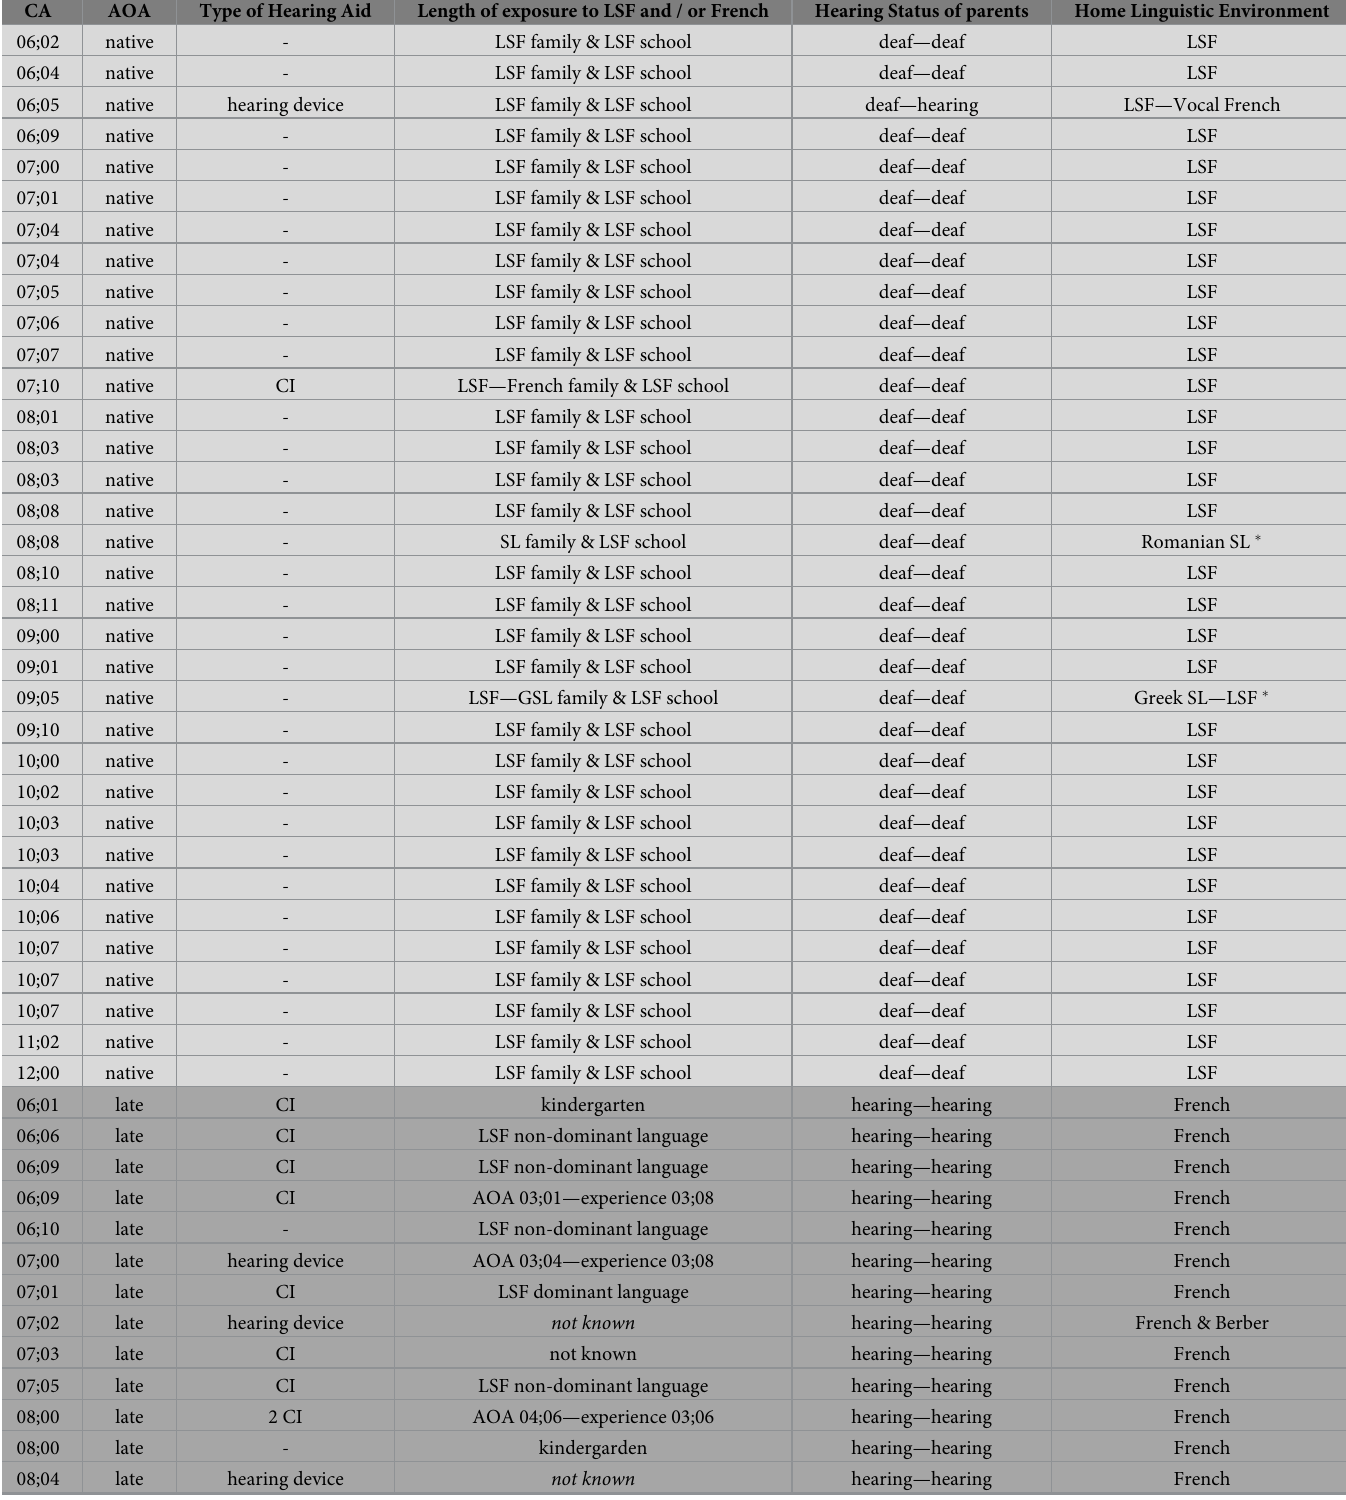
Table 1. Sociodemographic data on deaf children: 34 native signers and 28 non-native signers assessed with the SRT.